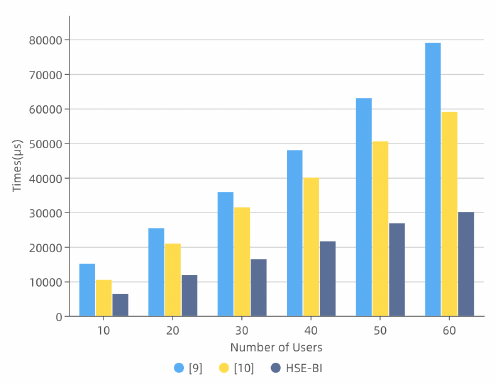
Figure 6. The Relationship between Number of Users and Search